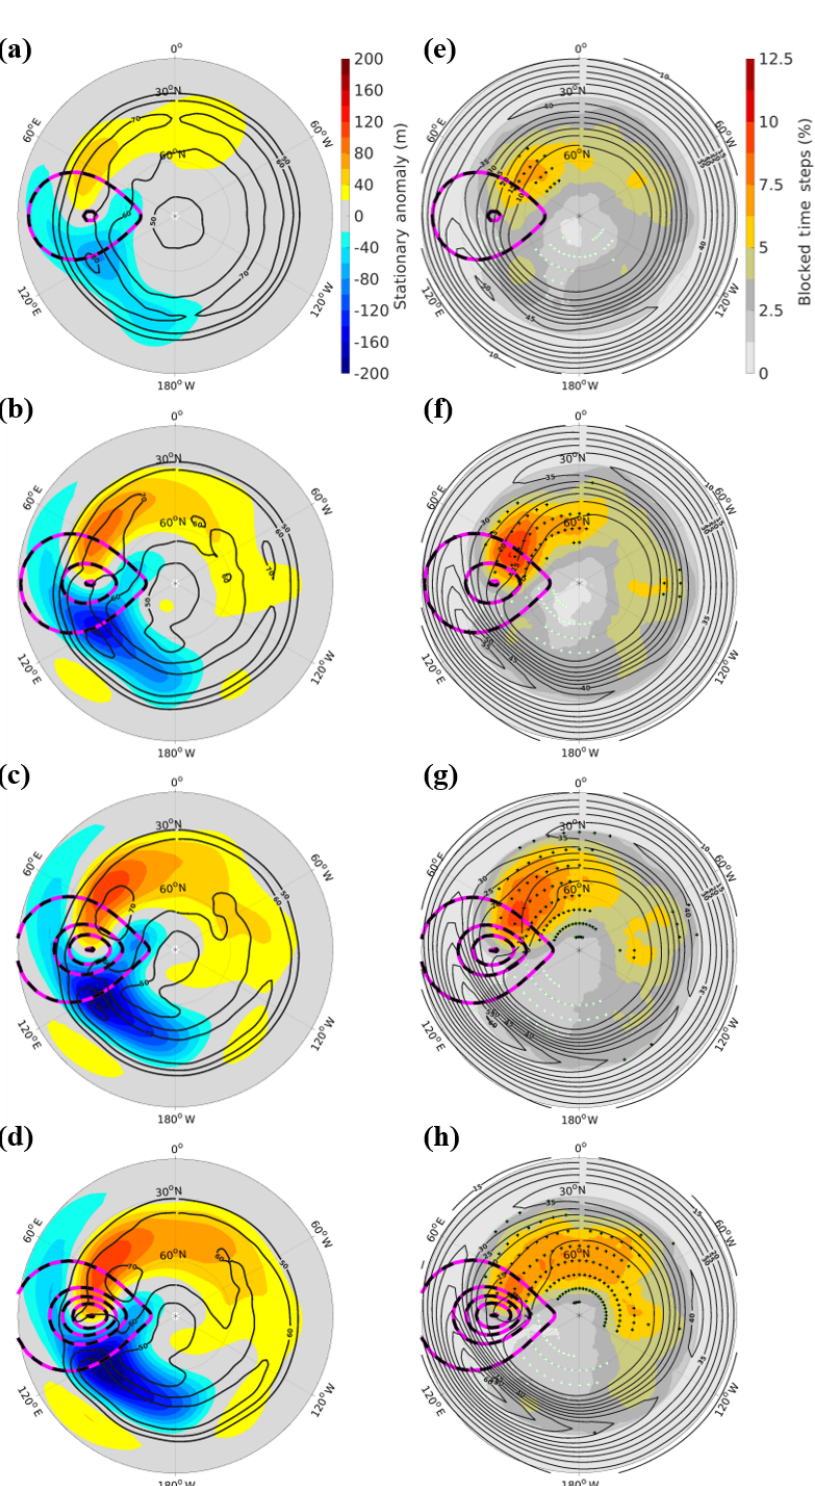
Figure 6. (a–d) Cool-season stationary wave (shading) and storm track (heavy black contours) for the (a) 1km, (b) 2km, (c) 3km, and (d) 4km mountain height integrations. Storm track contours are in 10m intervals where the outer contour is 50m. (e–h) Cool-season blocking climatology (shading) and U 250 (heavy black contours) for the (e) 1km, (f) 2km, (g) 3km, and (h) 4km mountain height integrations. U 250 contours are in 5ms − 1 intervals where the outer contour is 10ms − 1 . Black (white) stippling in (e–h) indicates significantly greater (lower) block frequency at nearby grid points when compared to a 250-year aquaplanet integration. Dotted pink and black contours represent surface height, where the outer contour is the edge of the land mask and the inner contours are in 1km